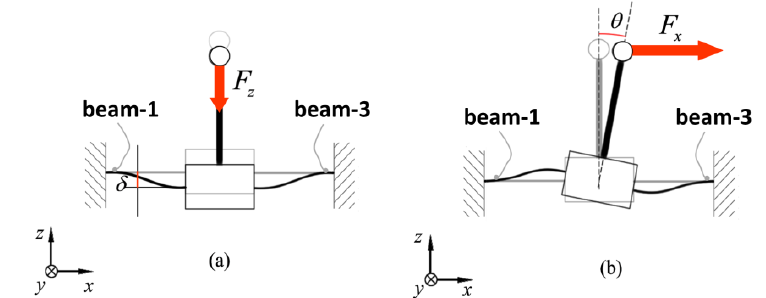
Figure 4. Possible load condition for the Maltese cross force-sensor: Condition A on the left ( a ) and Condition B on the right ( b